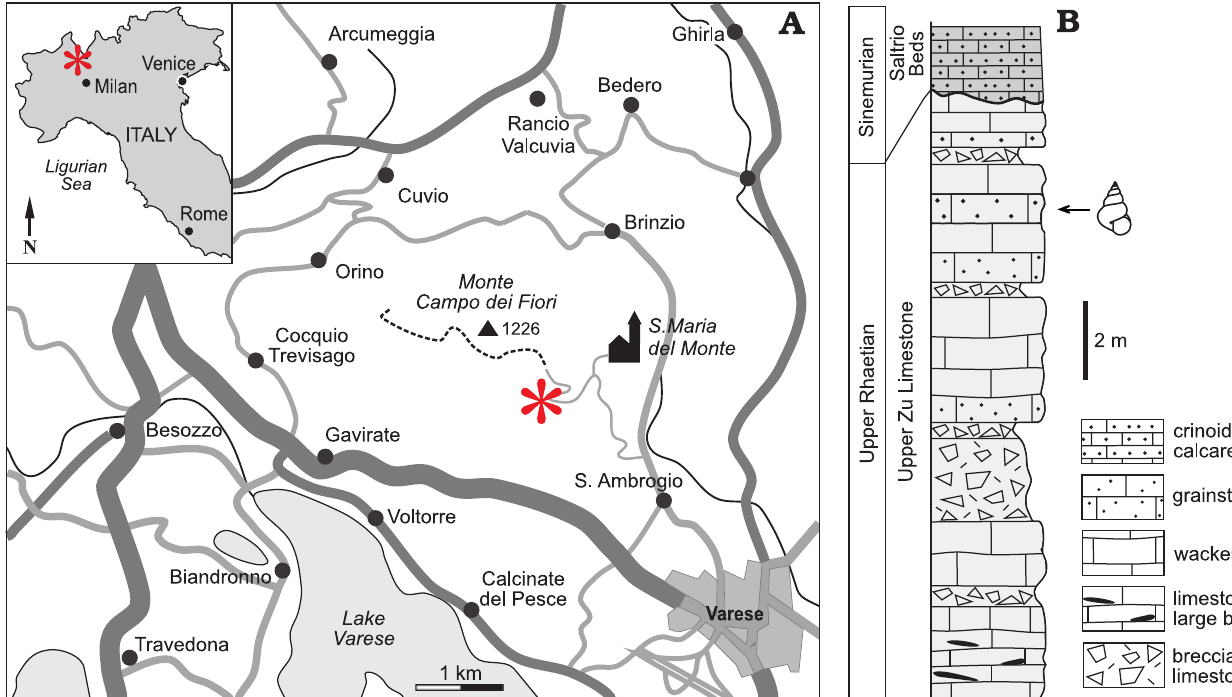
Fig. 1. Location of the outcrop ( A ) and stratigraphical section ( B ) modified from Jadoul et al.